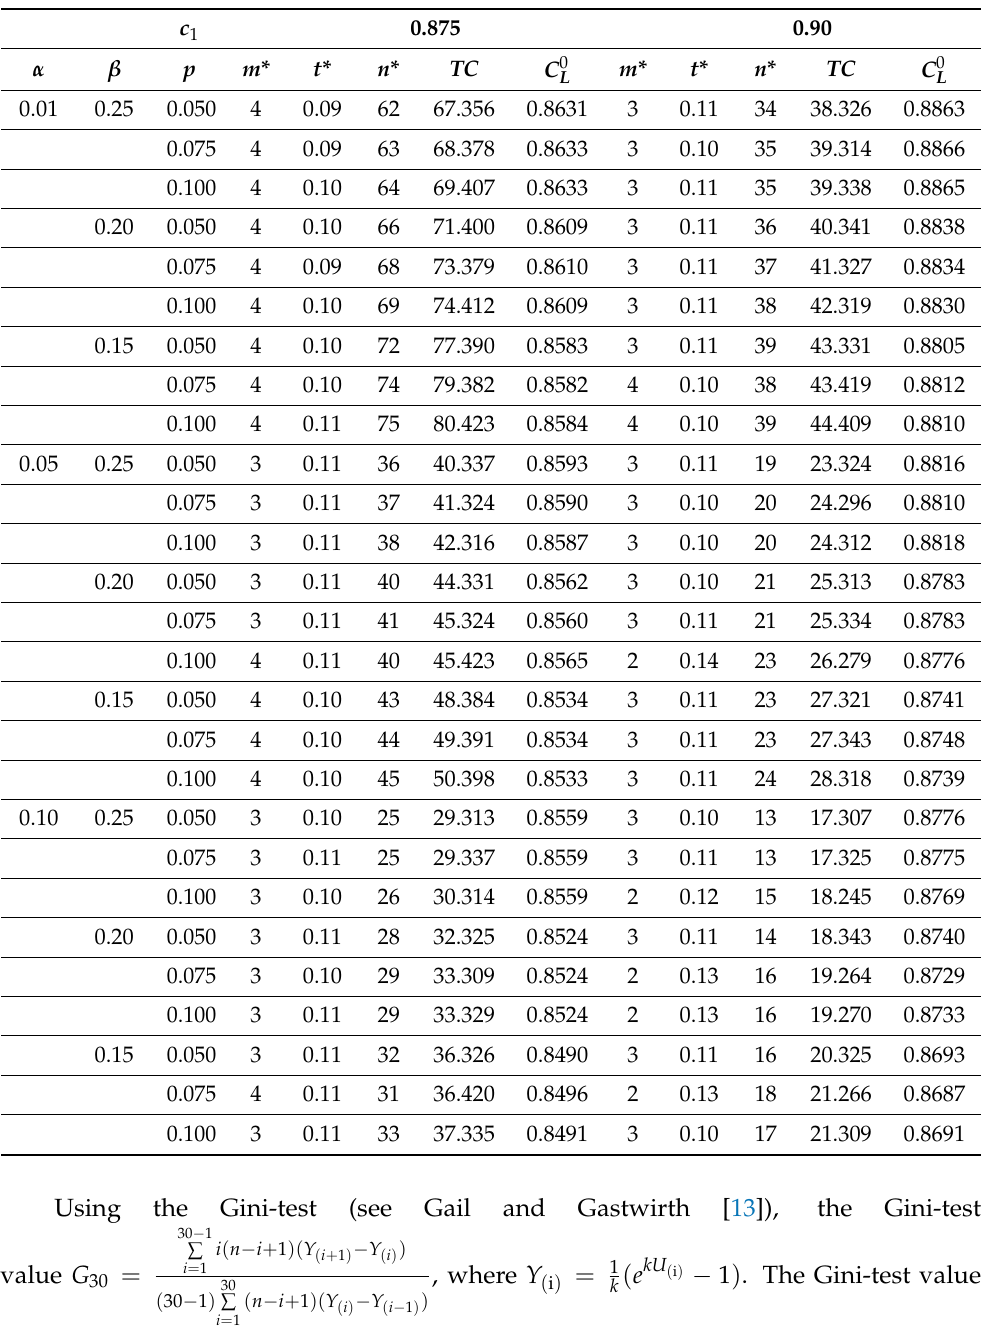
for c 1 = 0.875, 0.90 L